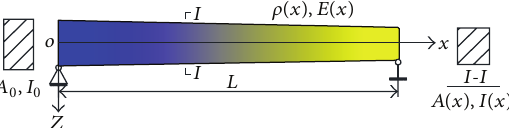
Figure 1: Schematic of an axially FG tapered